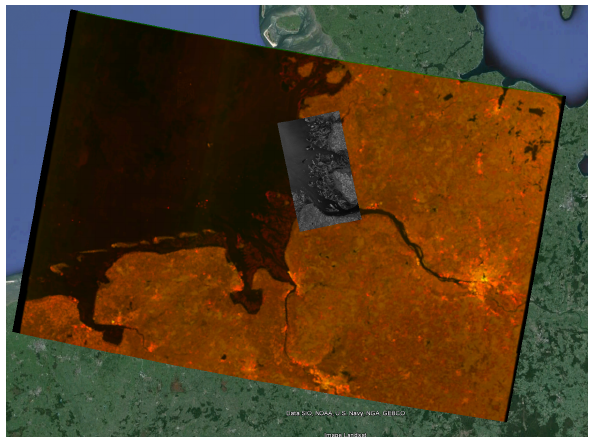
Figure 1: Comparison of the Sentinel-1 Interferometric Wide Swath scene and the TerraSAR-X stripmap scene over the North Sea coast. Background image c (cid:13) Google